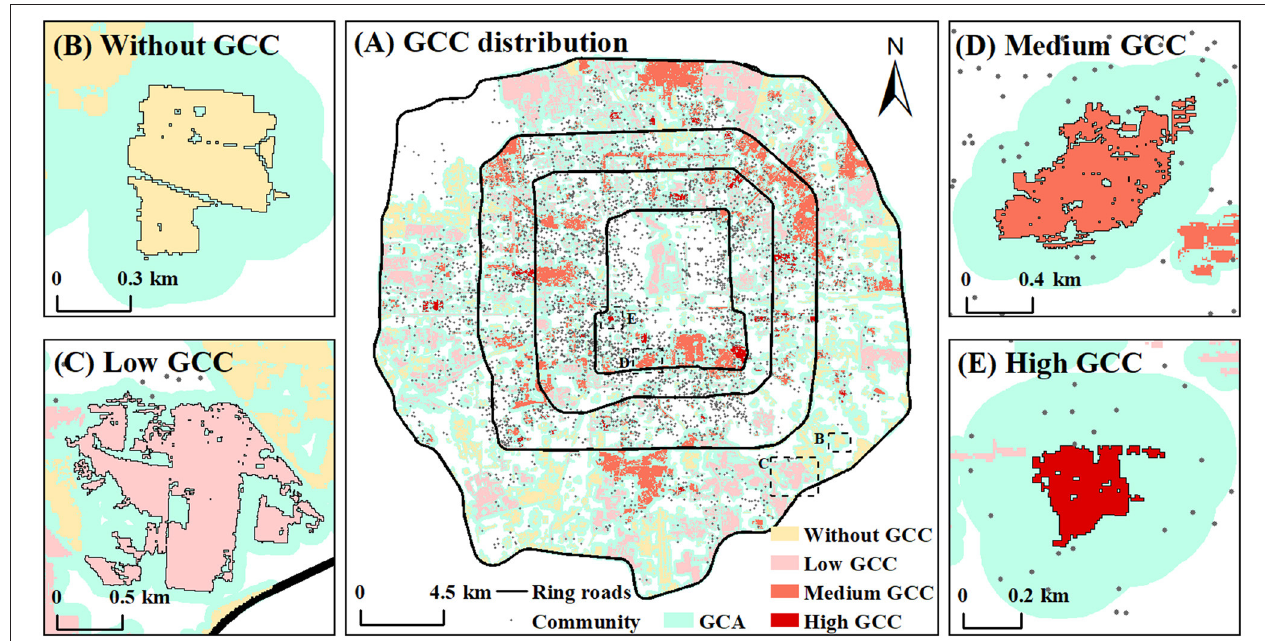
FIGURE 7 | Spatial distribution of green spaces with different GCC levels (A) , examples of green spaces with different GCC levels (B–E) .